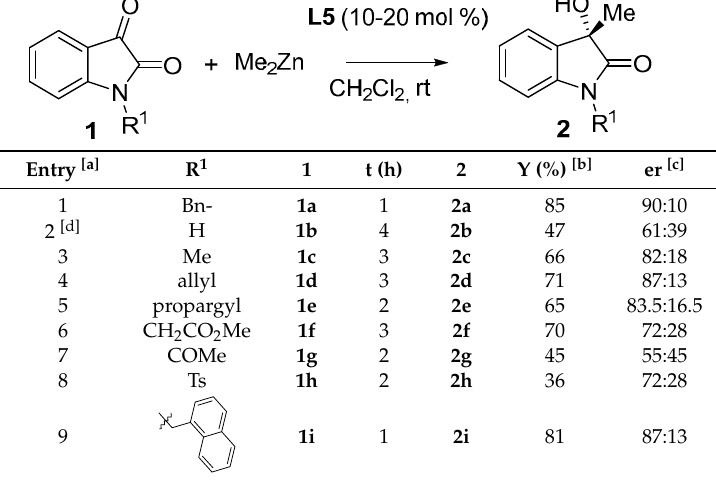
Table 3. Evaluation of the protecting group of the isatin.